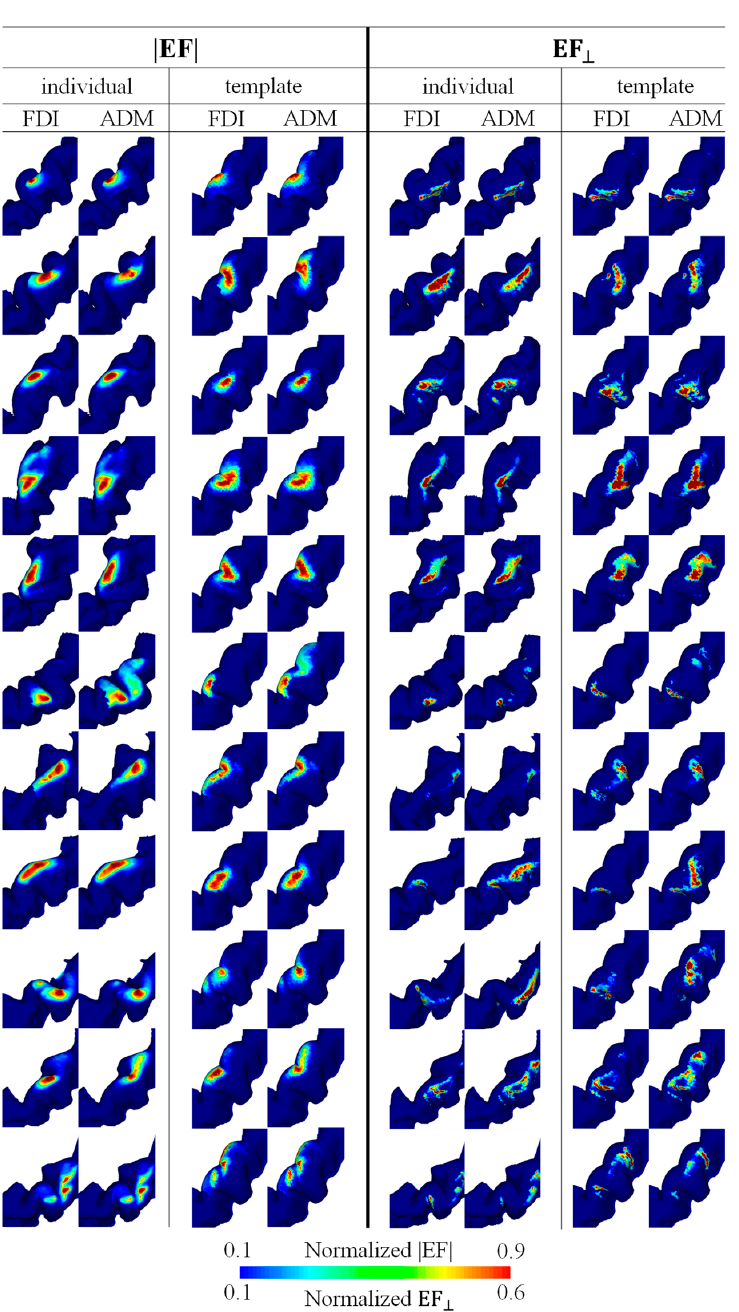
Figure 3. Individual brain motor mapping based on the absolute values of the electric field (|EF|) and the normal component of the electric field to the wall (EF ⊥ ). Brain mappings are shown in the individual and standard brain space for each target muscle (FDI and ADM). Five and three samples were used for mapping with the |EF| and EF ⊥ ,